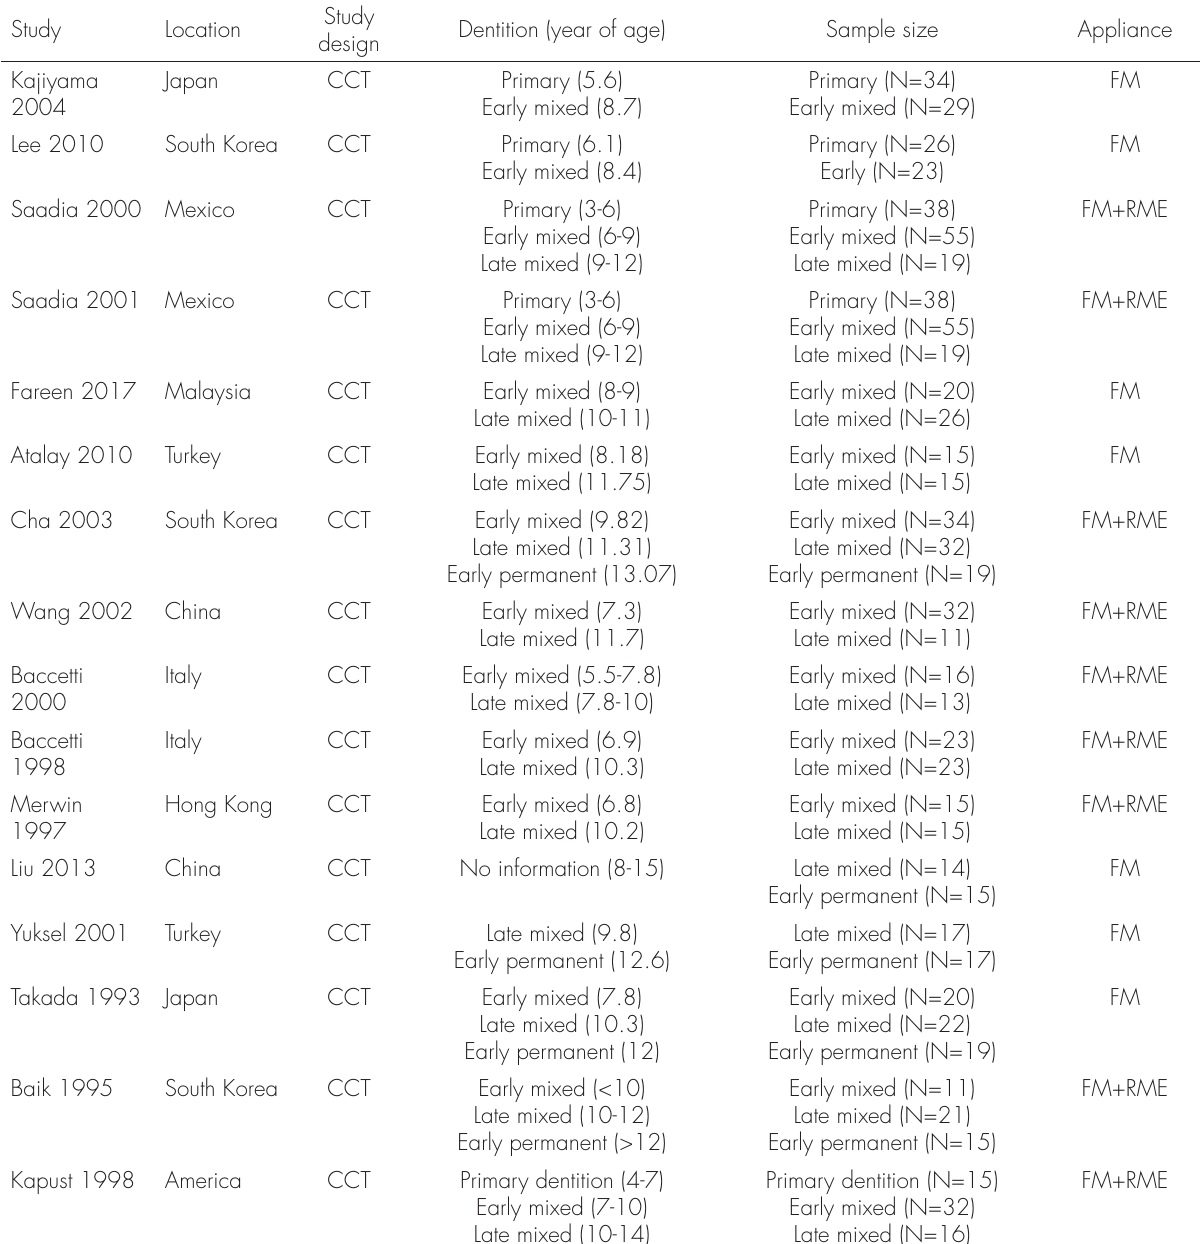
Table II. Characteristics of the included